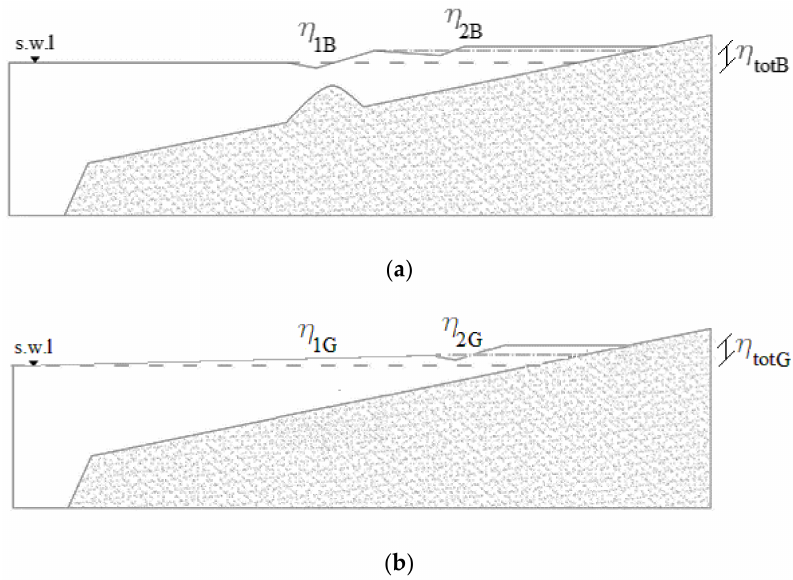
Figure 4. Schematic cross-section and profile of the set-up; ( a ) section placed over the submerged breakwater ( b ) section placed in the gap between the barriers.